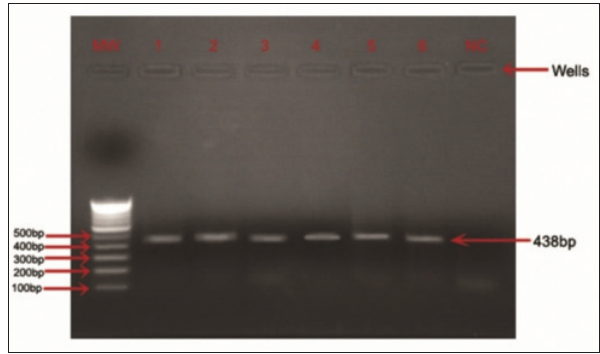
Figure-1: Amplification of myostatin (exon 3) gene using the specific primer of polymerase chain reaction in Marwari goats visualize under ultraviolet illuminator stained with ethidium bromide. MW: Molecular weight